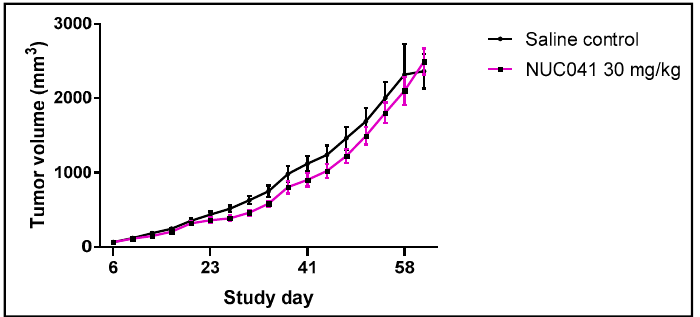
Figure 3. Comparison of mean tumor volumes (±SEM) in mice with human colon cancer (LoVo) implants treated with NUC041 30 mg/kg IV administered three consecutive days per week for three weeks vs. SC. ( n = 10 per group).